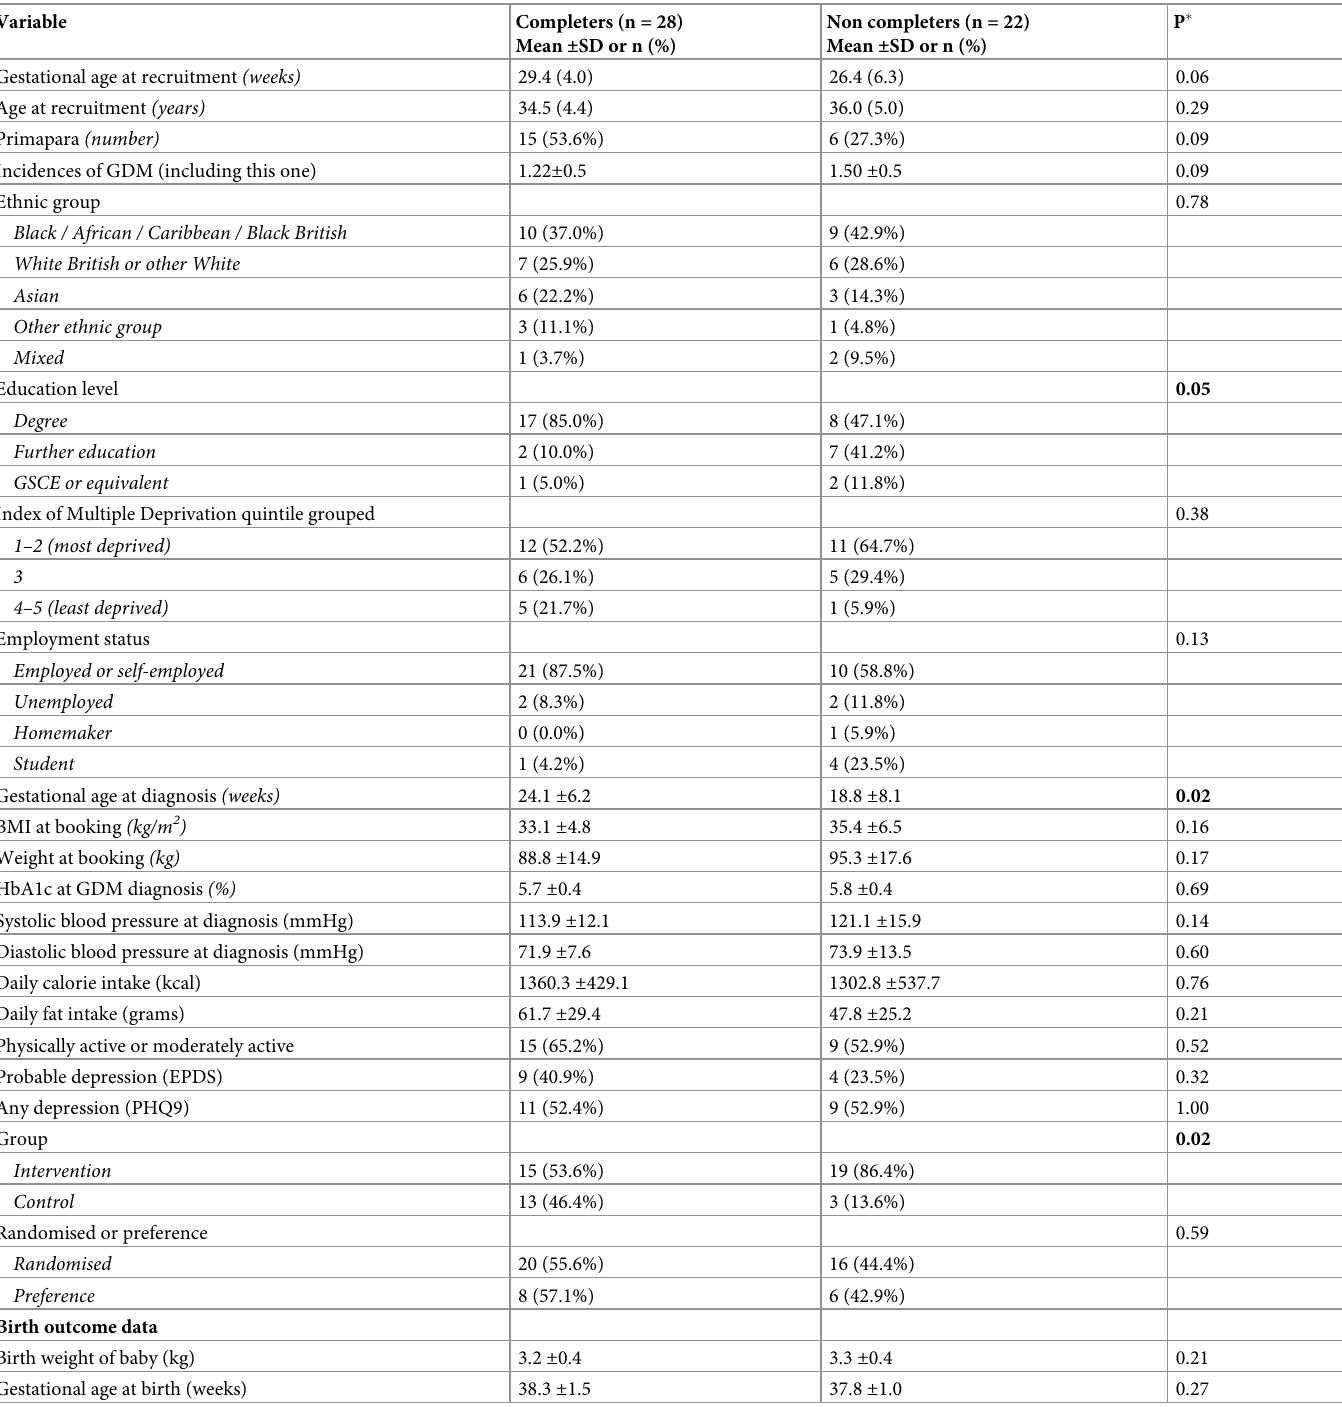
Table 2. Baseline and birth outcome data by completers and